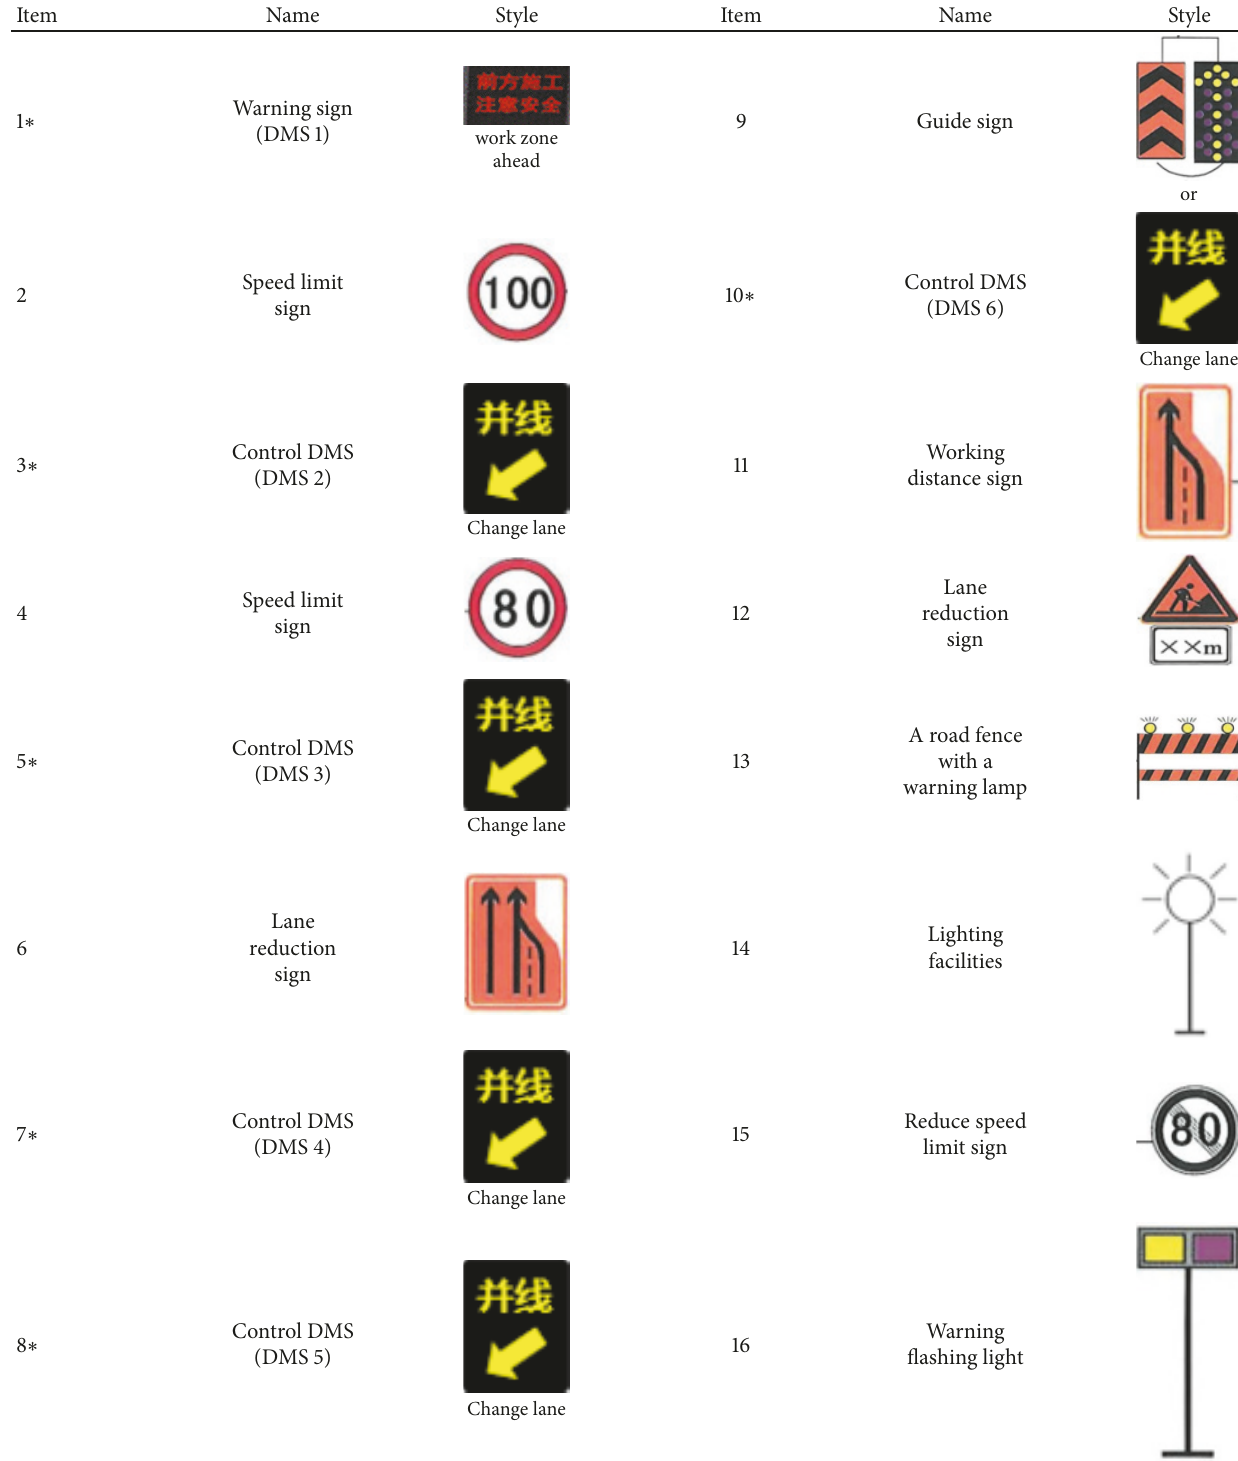
Table 2: Names and styles of the signs in work